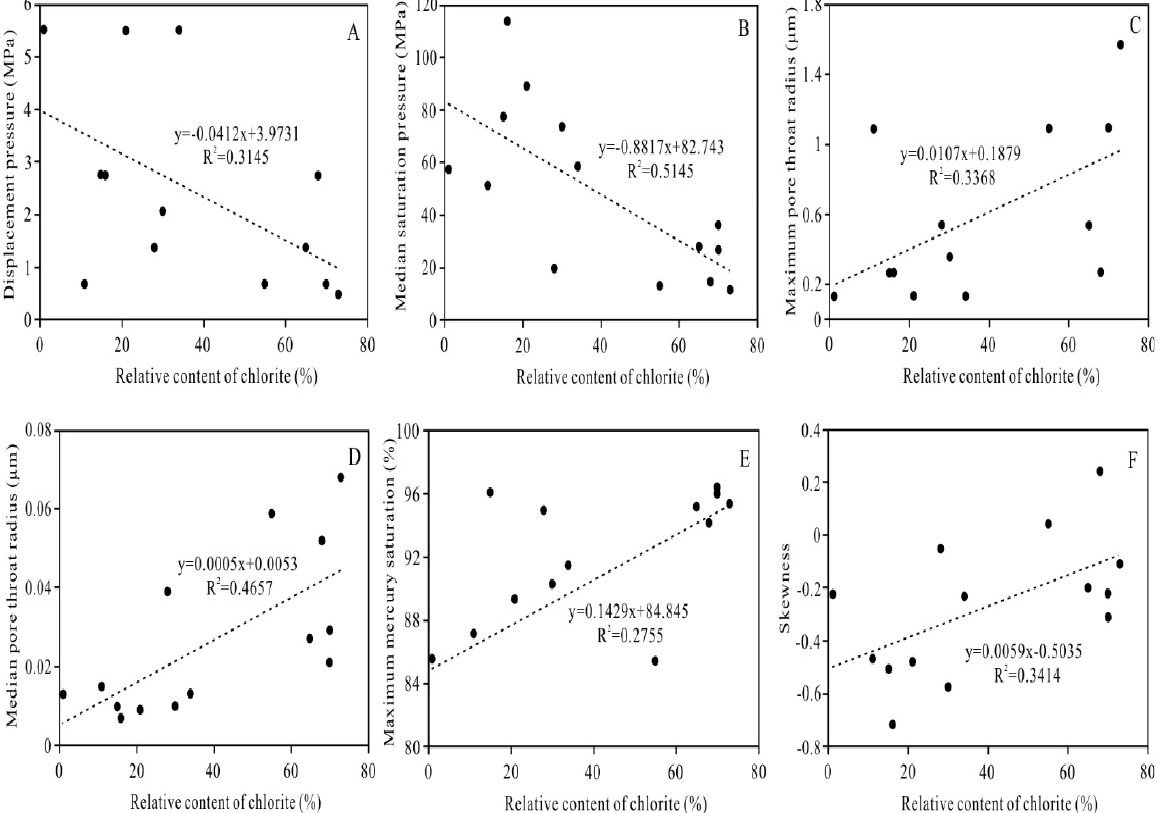
Figure 15. Relationship between the relative content of chlorite and ( A ) Displacement pressure, ( B ) Median saturation pressure, ( C ) Maximum pore throat radius, ( D ) Median pore throat radius, ( E ) Maximum mercury saturation, and ( F ) Skewness.